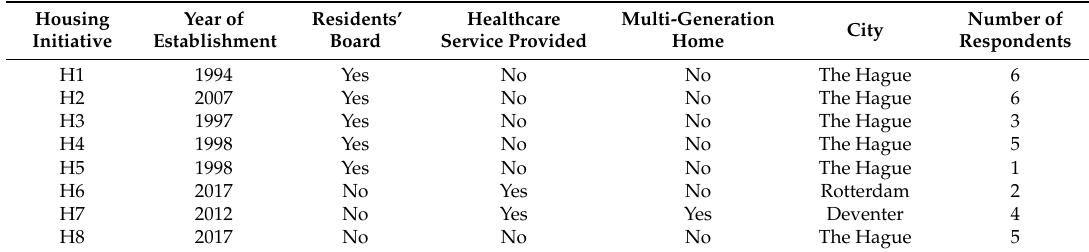
Table 1. Overview senior collaborative housing initiatives.